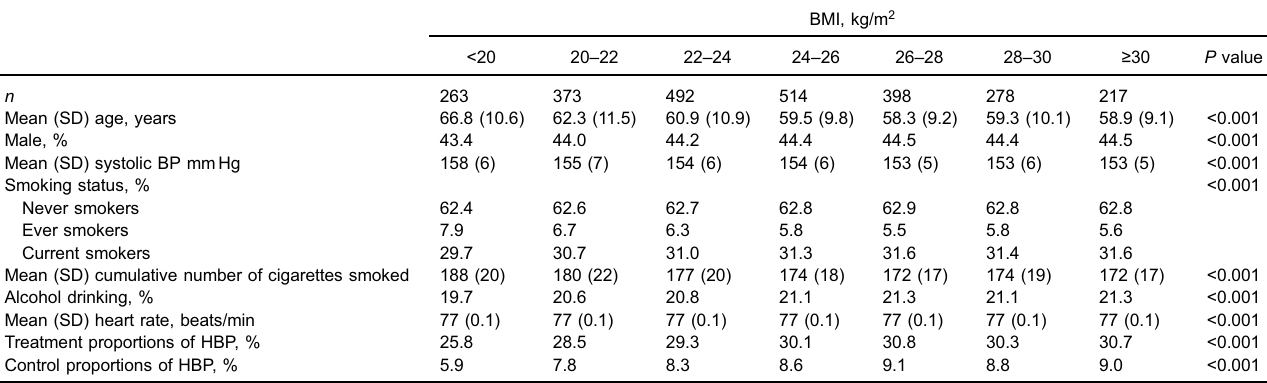
Table 1. Age-adjusted baseline characteristics according to BMI categories among patients with hypertension